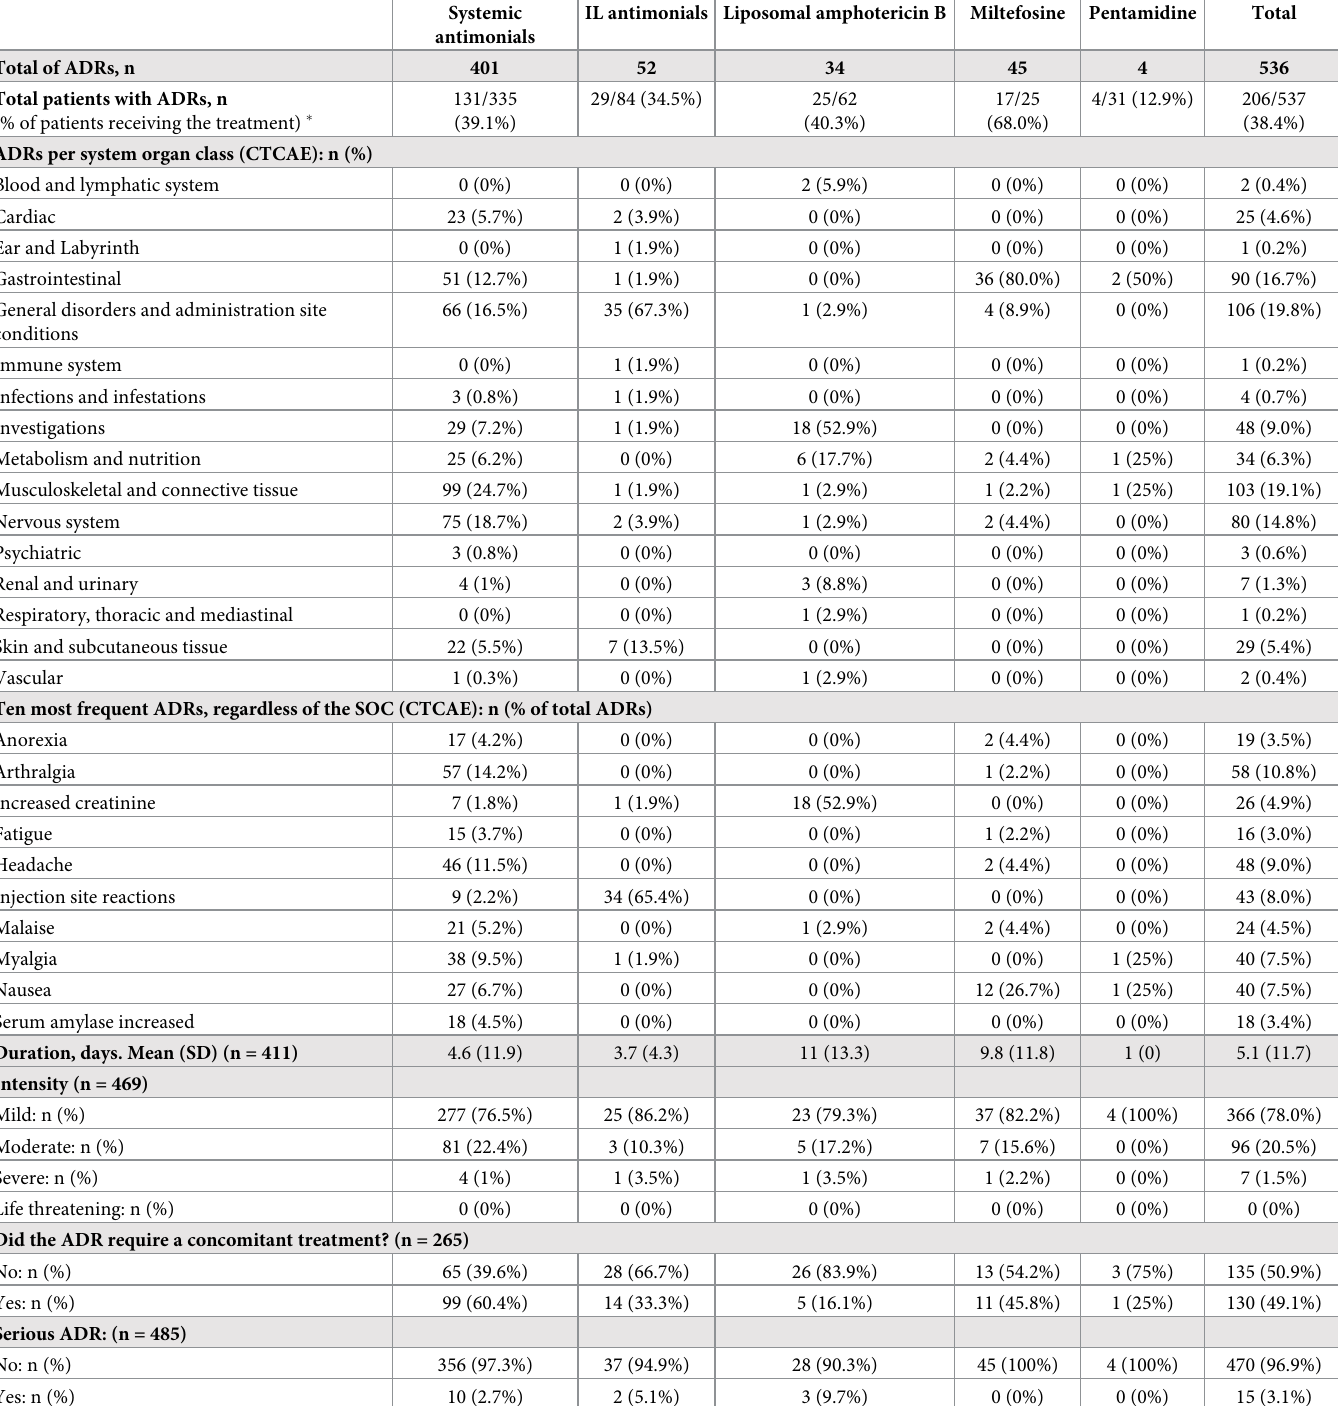
Table 5. Adverse drug reactions in adults � 60 years